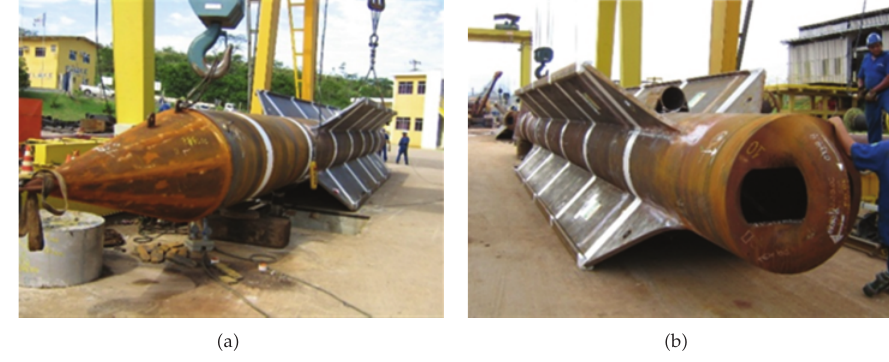
Figure 1: Typical torpedo anchor with four flukes: (cid:3) a (cid:4) conical tip and (cid:3) b (cid:4) top with detail of the padeye.